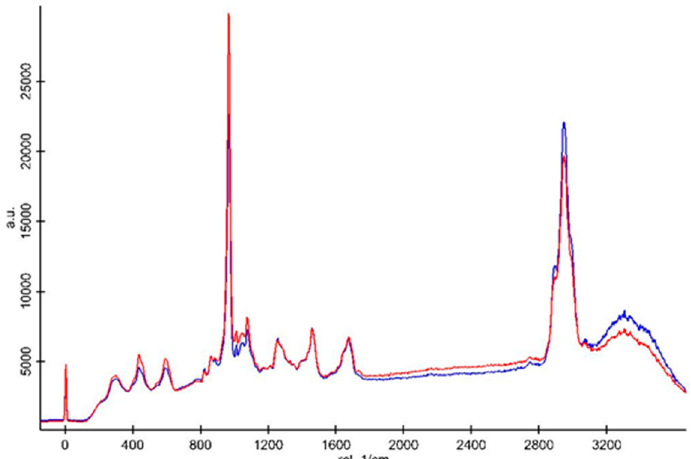
Figure 5. Representative Raman spectra of the dentin bridge (red line) and primary dentin (blue line) of the Biodentine ™ group. The spectra were normalized based on the peak intensity of the CH 2 bending vibration at 1450 cm − 1 .